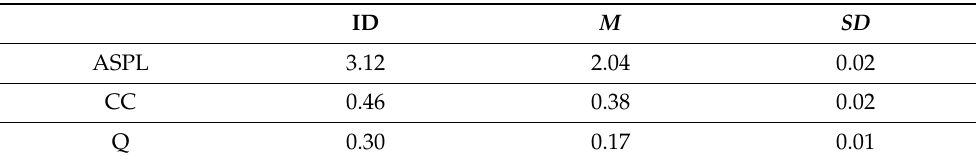
Table A10. Random Network comparison for the network of the adolescents with ID (dataset 9), p < 0.001 for all comparisons.